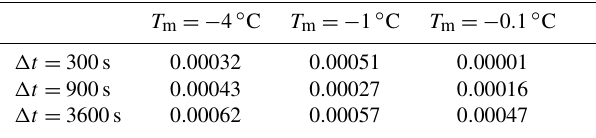
Table 4. Maximum error (m) of the freezing front position from the numerical solution with the NCZ algorithm relative to the Lunardini analytical solution. The space resolution is (cid:49)x = 0 . 01m.